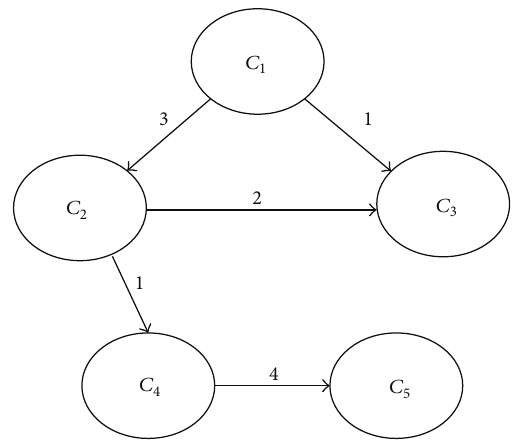
Figure 1: Example of an influence